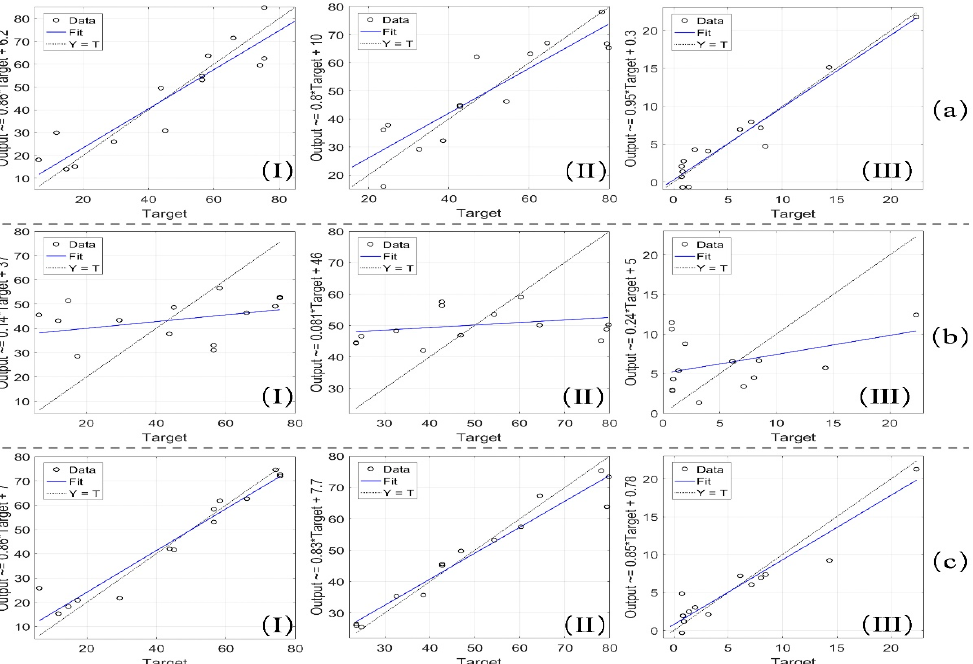
Figure 11. Regression between predicted and true values of ( a ) MLR, ( b ) PLSR, and ( c ) SVM models, (I) sand, (II) silt, and (III) clay content using FLAASH atmospheric correction surface reflectance data.